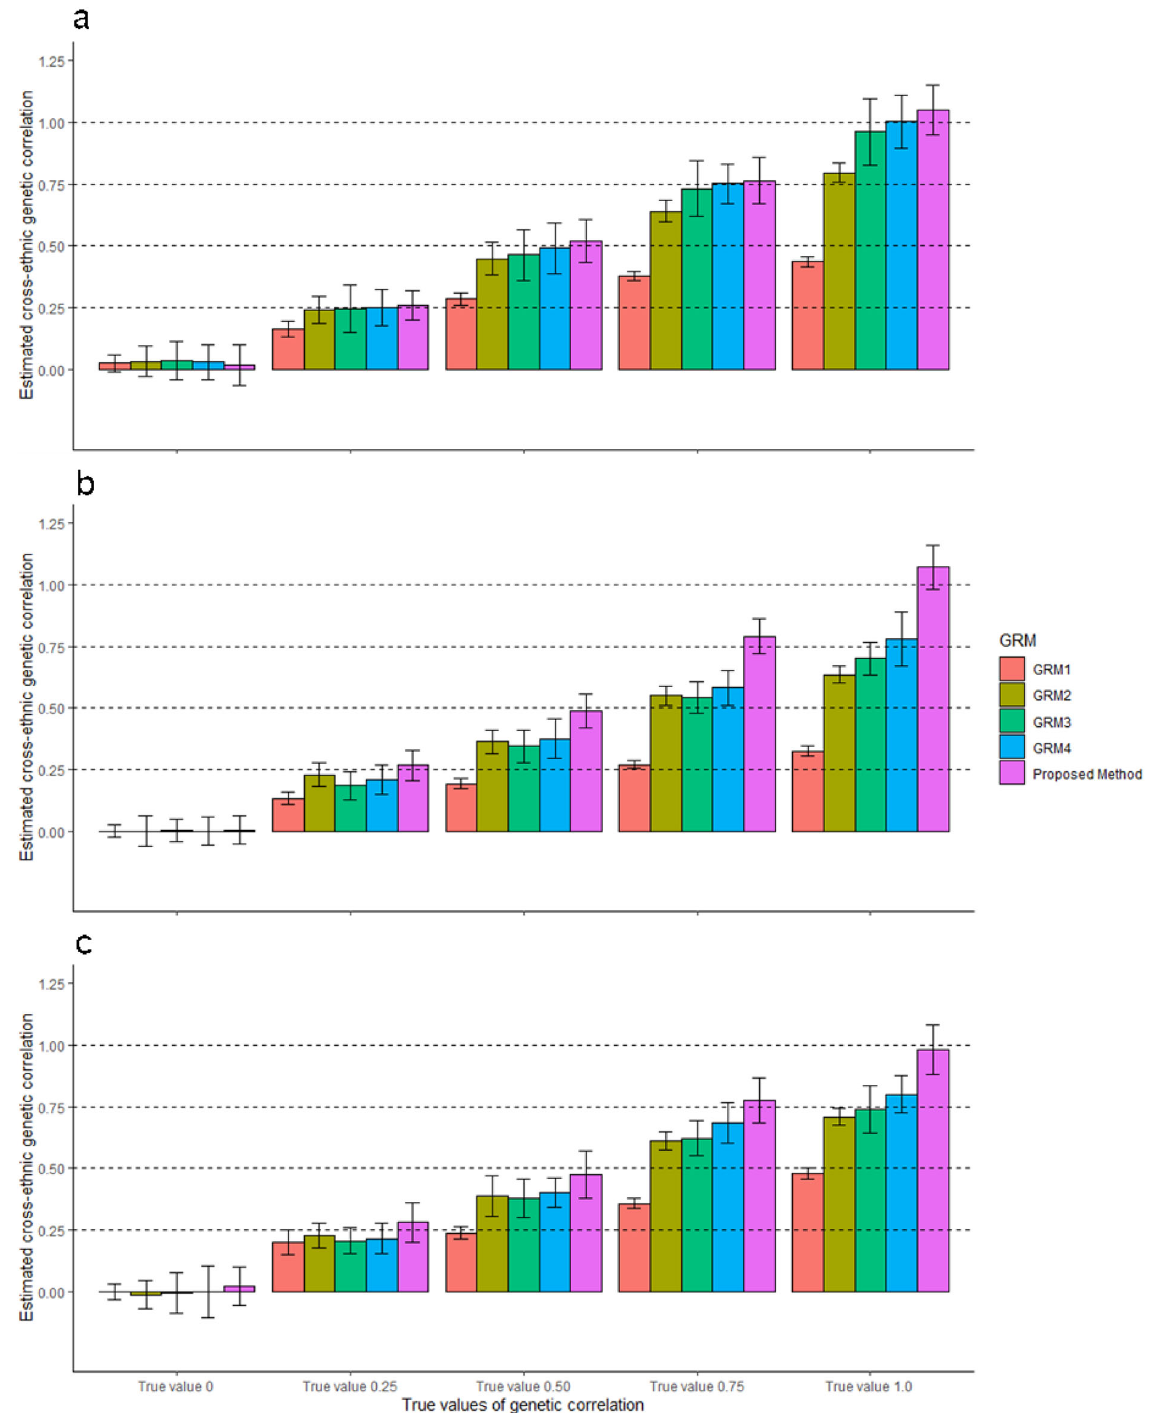
Fig. 3 | Estimated cross-ancestry genetic correlations from four existing methods when varying α values across ancestry groups. The main bars repre- sent the averages of estimated cross-ancestry genetic correlations, and the error bars indicate 95% con fi dence interval (CI) of the averages, which are derived from 500experimentalreplicatesthatwereindependentlycarriedout.Inoursimulation, we used three combinations for estimating cross-ancestry genetic correlation, i.e., a White British vs. South Asian, b White British vs. African and c South Asian vs. African ancestrycohorts.In eachancestrygroup,we used 500,000SNPs that were randomly selected from HapMap3 SNPs after QC. To simulate phenotypes, we selected a random set of 1000 SNPs as causal variants, which were presented for both ancestry groups. We used various α values that were speci fi c to ancestries ( α = − 0.25, − 0.625 and − 0.75 for White British, South Asian and African ancestry